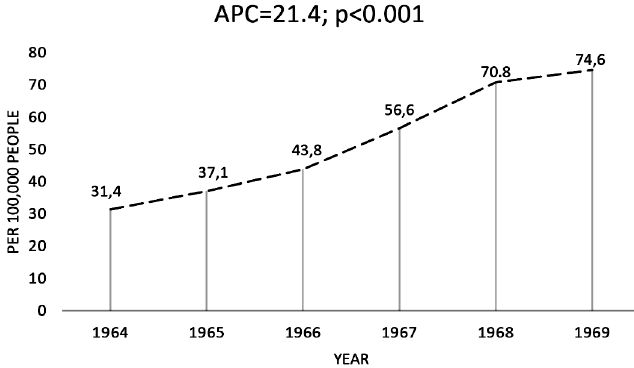
Figure 4. Syphilis incidence rates in the years